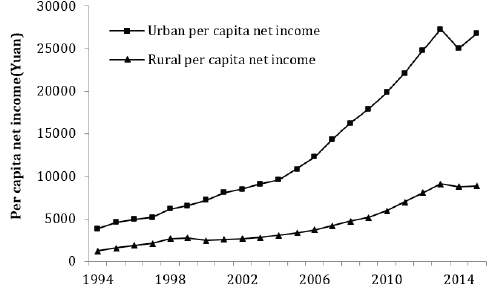
Figure 12. Urban and rural per capita net income.